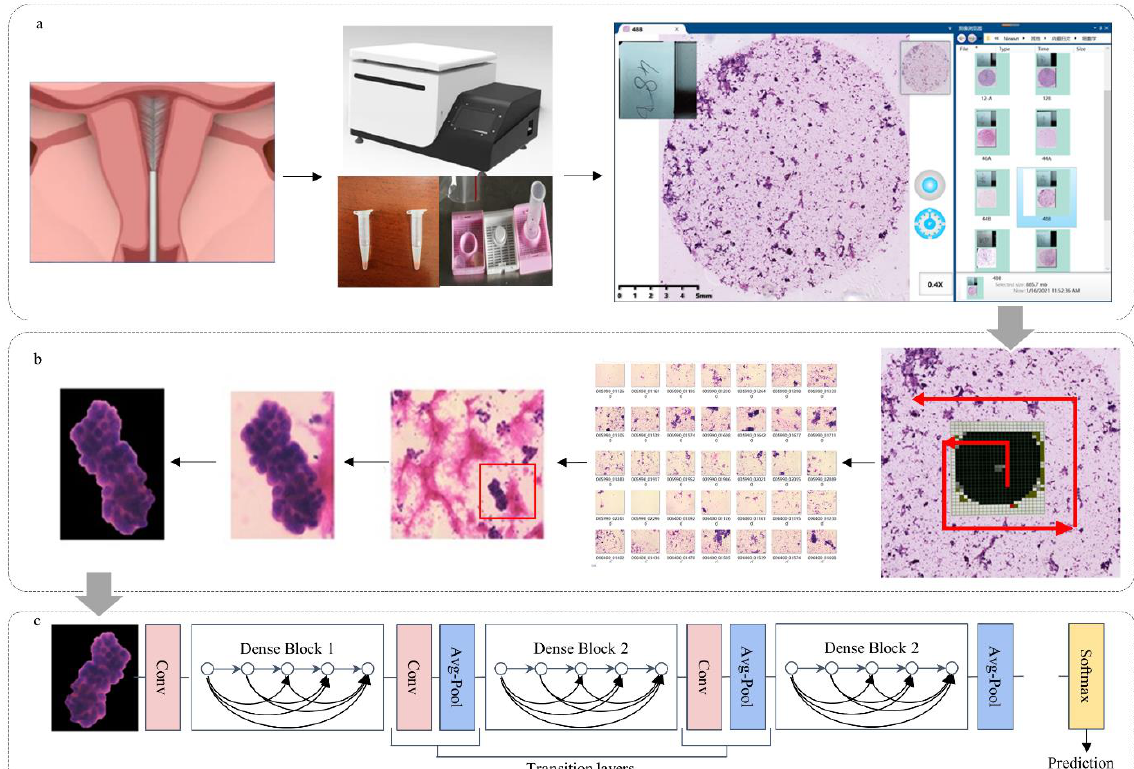
Figure 1. The process of obtaining images and recognition. ( a ) Sampling procedure; ( b ) cytological slides diagnosis; ( c ) classification using endometrial cytological images feature.